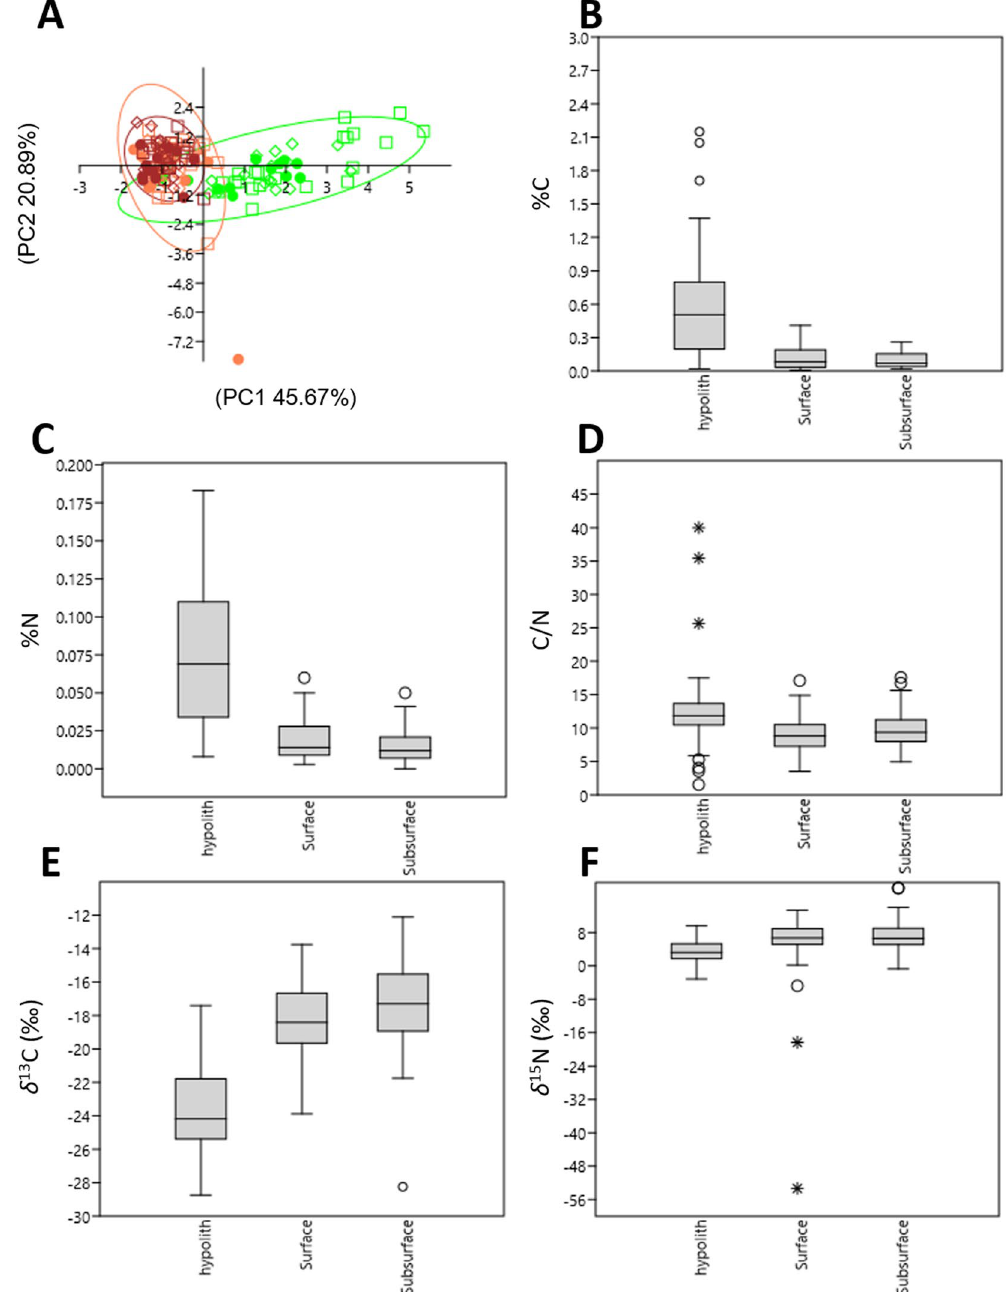
Figure 2. Namib Desert hypolith, surface and subsurface soil C and N chemistry comparative analyses. ( A ) PCA plot of C and N chemistries. Hypoliths are indicated in green, surface soils in orange and subsurface soils in brown. ● 2016; ◊ 2015; □ 2014. Ellipses indicated 95% confidence. ( B ) Habitat-specific boxplot of %C. ( C ) Habitat-specific boxplot of %N. ( D ) Habitat-specific boxplot of C/N ratios. ( E ) Habitat-specific boxplot of δ 13 C. ( F ) Habitat-specific boxplot of δ 15 N. Boxplot outliers are indicated by ○ and *